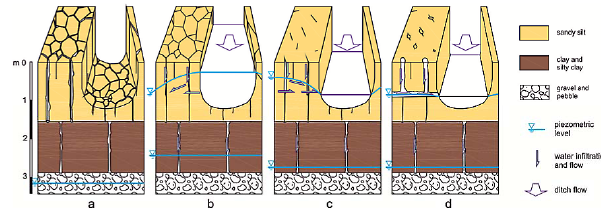
Fig. 16. Supposed developing sequence for sinkhole-like features caused by flows between water table and ditches ( (a) , dry period; (b) , beginning heavy rainfall; (c) , just after rainfall; (d) , approxi- mately 10–15days after the rainfall